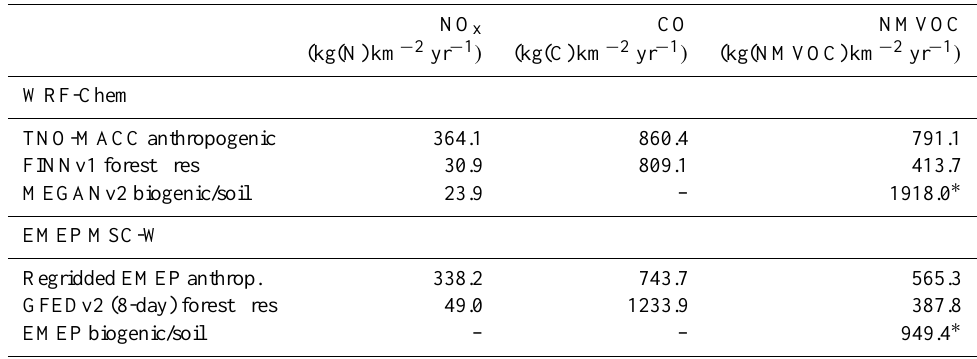
Table 2. Emissions from various sources averaged over the region marked by the dashed line in Fig. 2 (11–30 ◦ E, 32–45 ◦ N) and for the summer period (June, July, August) of 2007, as used in the reference simulations of the two models.